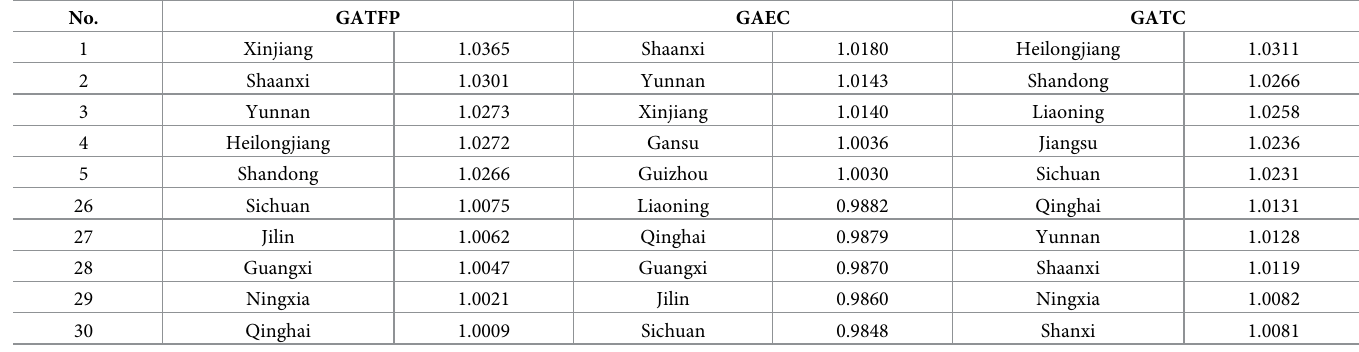
Table 3. Top and bottom five rankings of GATFP, GAEC and GATC in China.